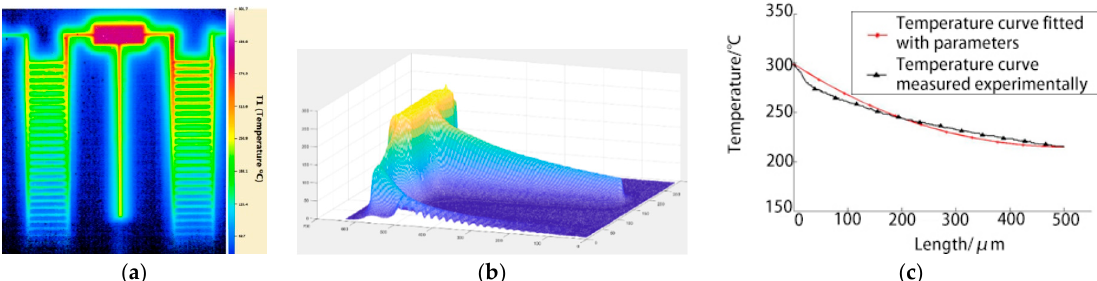
Figure 3. Fitting curve of heat transfer parameters: (a ) Temperature field of long straight beam; ( b ) numerical Matrix at